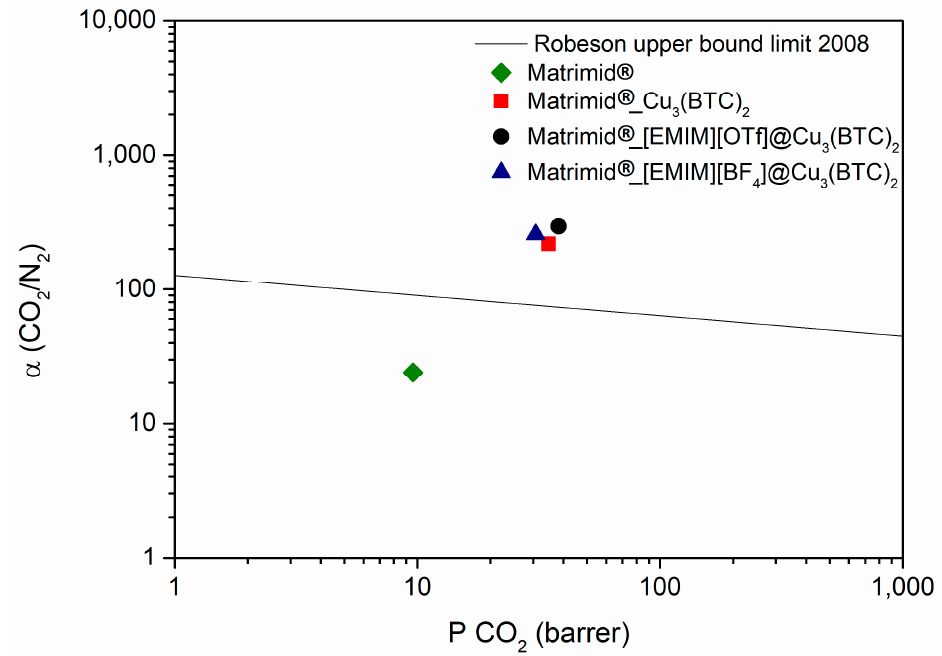
Figure 8. CO 2 /N 2 ideal selectivity as a function of CO 2 permeability for the MMMs prepared. Comparison with the 2008 Robeson upper bound for CO 2 /N 2 separation [21].